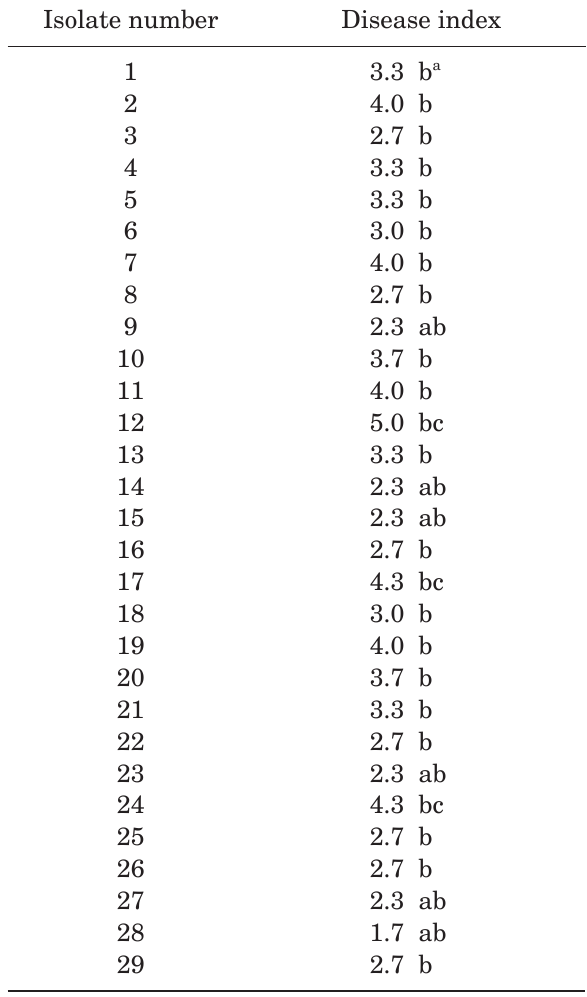
Table 2. Pathogenicity of Sclerotinia homoeocarpa iso - lates on Agrostis stolonifera , expressed as mean disease index, from 0 to 5 (see